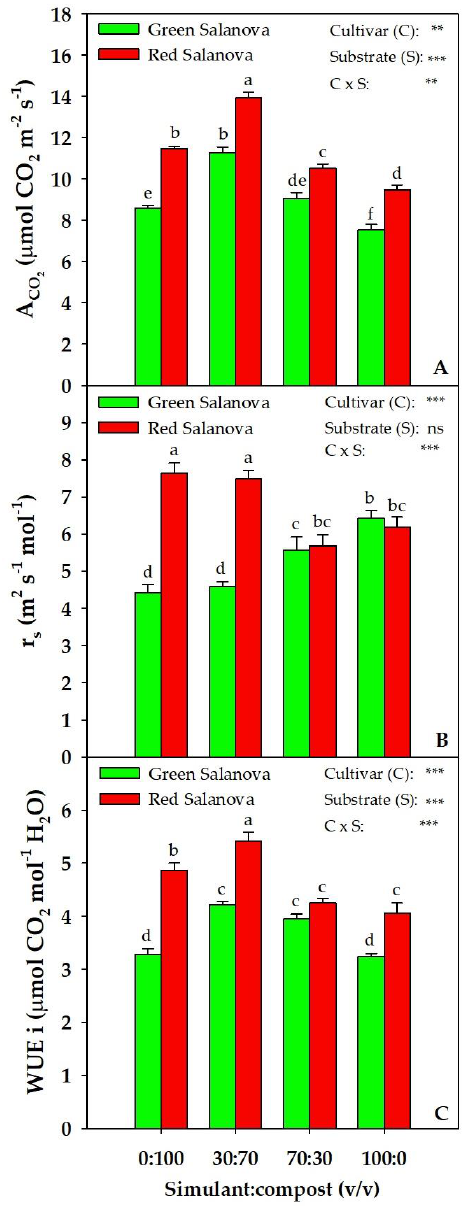
Figure 2. Physiological parameters: net CO 2 assimilation rate (A CO2 ) ( A ), stomatal resistance (r s ) ( B ) and intrinsic Water Use E ffi ciency (WUEi) ( C ) of green and red Salanova lettuce, as influenced by substrate mixtures (four different rates of MMS-1 simulant:compost v:v). Different letters above bars indicate significant mean differences according to Duncan’s multiple range tests ( P ≤ 0.05). Vertical bars indicate ± SE of means. ns,**, *** Non-significant or significant at P ≤ 0.01 and 0.001, respectively. As for total nitrogen and nitrate expressed on a fresh weight basis (Table 2), no significant di ff erence was found, neither for the cultivar and substrate factors mean e ff ect nor for their